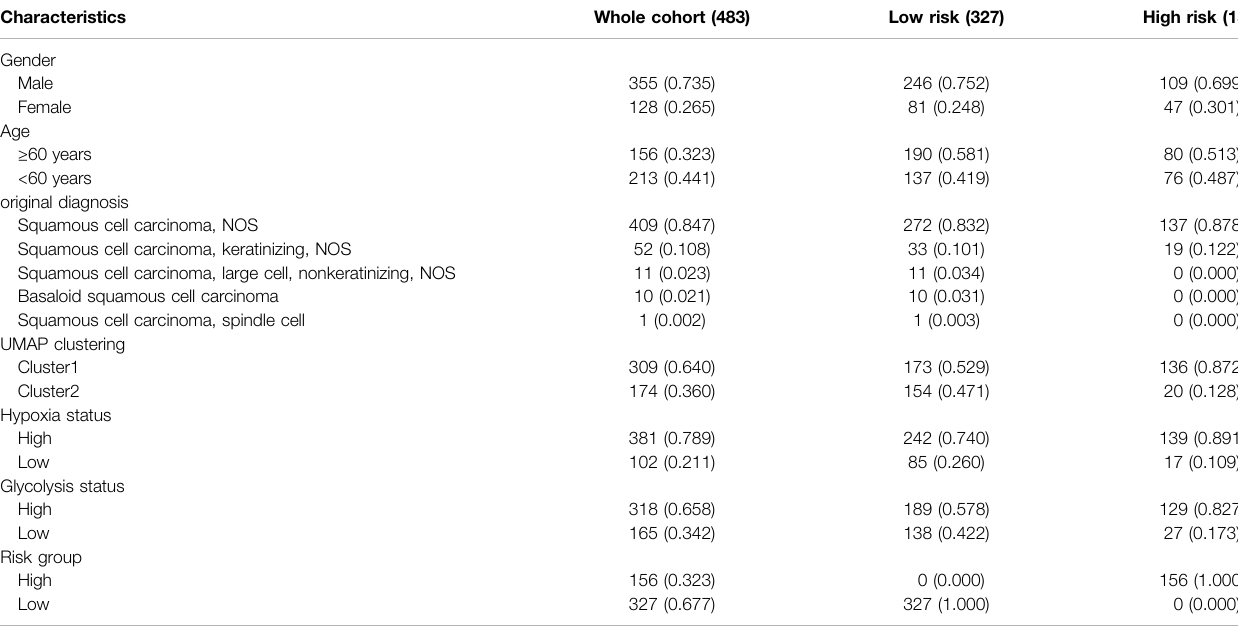
TABLE 1 | Basic information of HNSCC patients in discovery